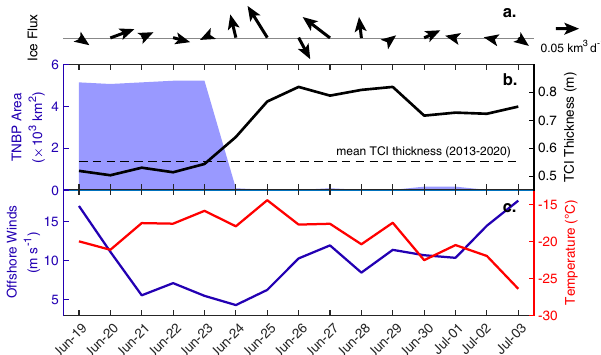
Fig. 2 Factors in fl uencing the TNBP area variation from 19 June to 03 July, 2013. a Mean winds over the TCI region. b TNBP extent (blue area) and the thickness of TCI (black line). c Offshore wind speed (blue line) and air temperature (red line) from